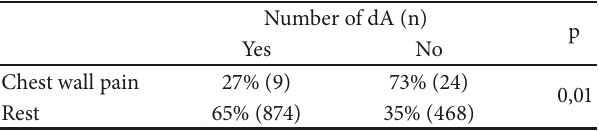
Table 4: dA for “chest wall pain” compared to the remaining diagnoses.